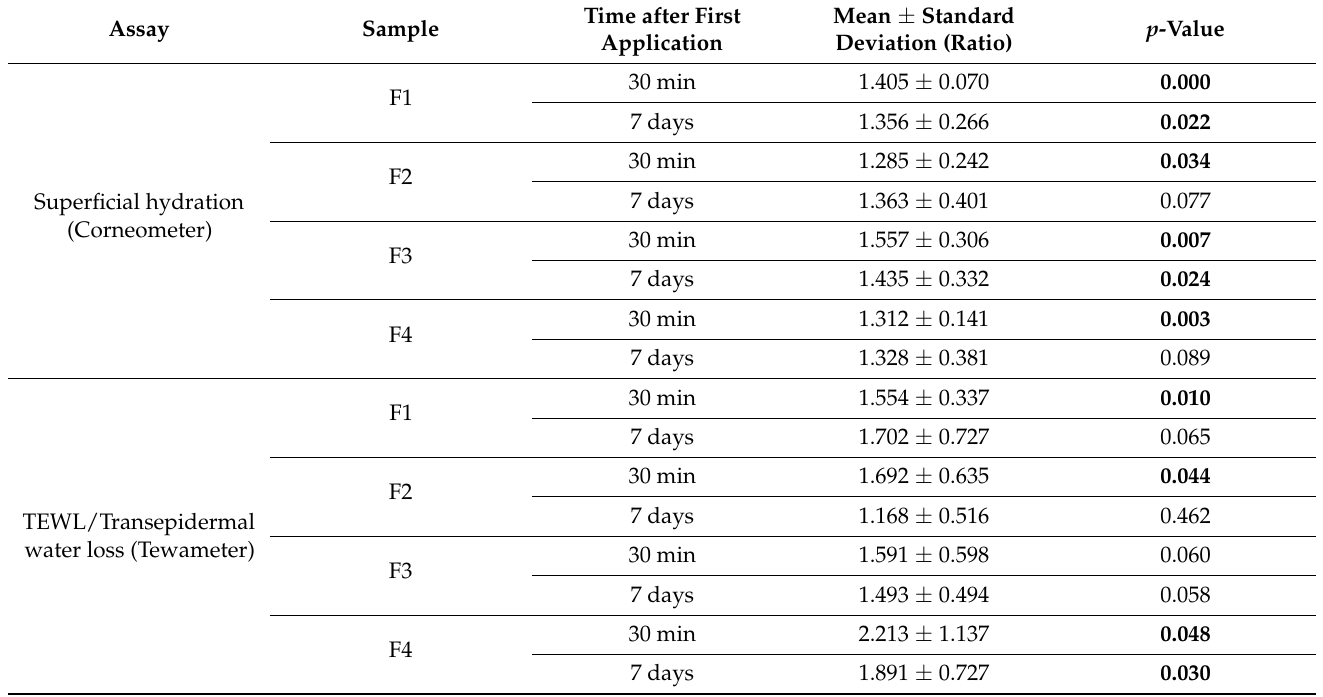
Table 2. In vivo skin biocompatibility by the corneometer, Tewameter TM 300, pH meter, and chromameter.